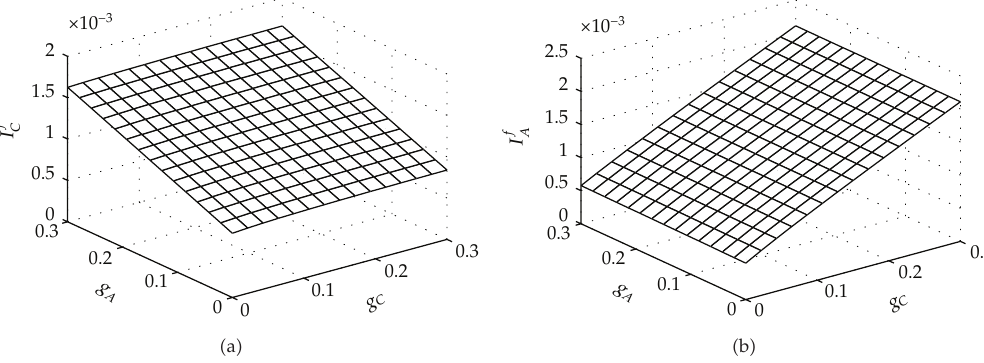
Figure 7: Component I C (cid:5) a (cid:6) and component I A (cid:5) b (cid:6) of endemic equilibria E f . Here, R 0 > 1 when g C (cid:8) g A (cid:8) 0.